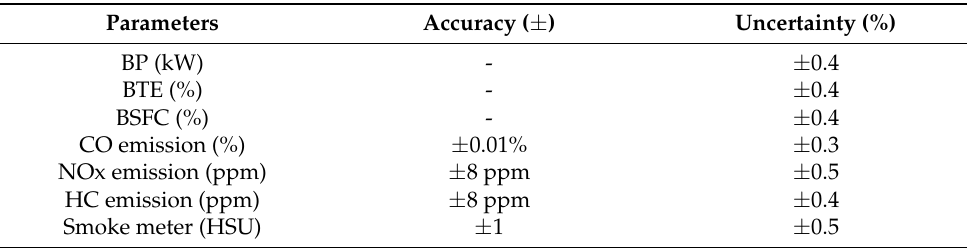
Table 3. Uncertainty and accuracy levels of performance and emission parameters.